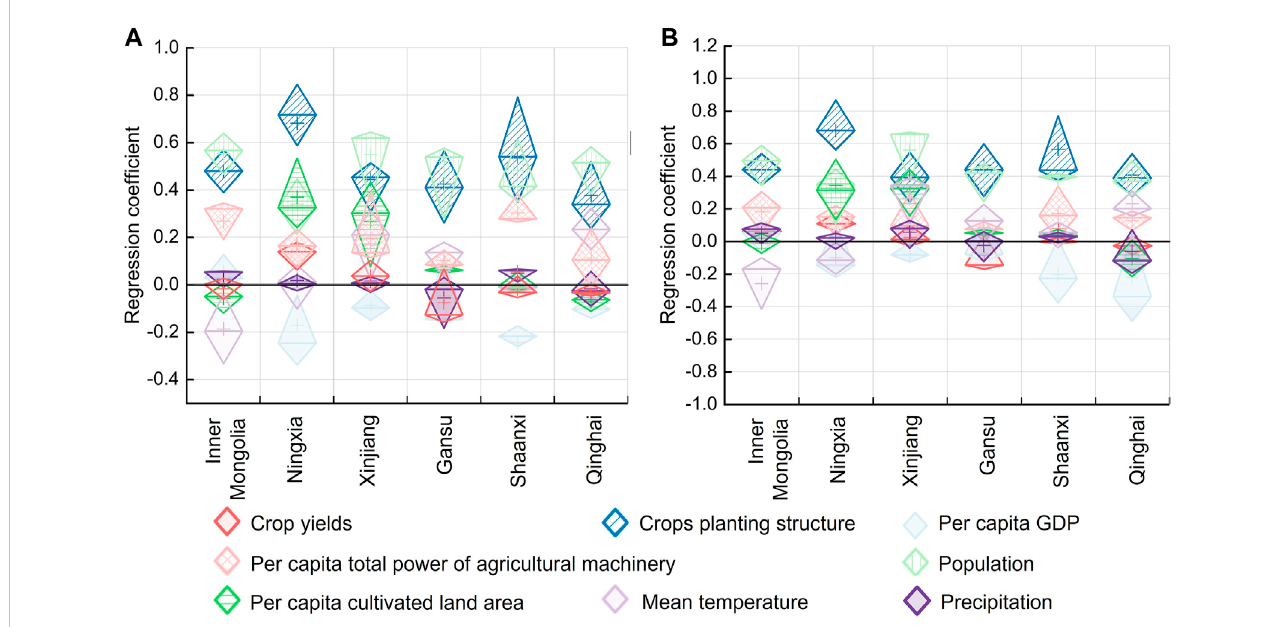
FIGURE 4 Boxplot of the driving force of the total GWF related to N (A) and P (B) in the six western provinces.